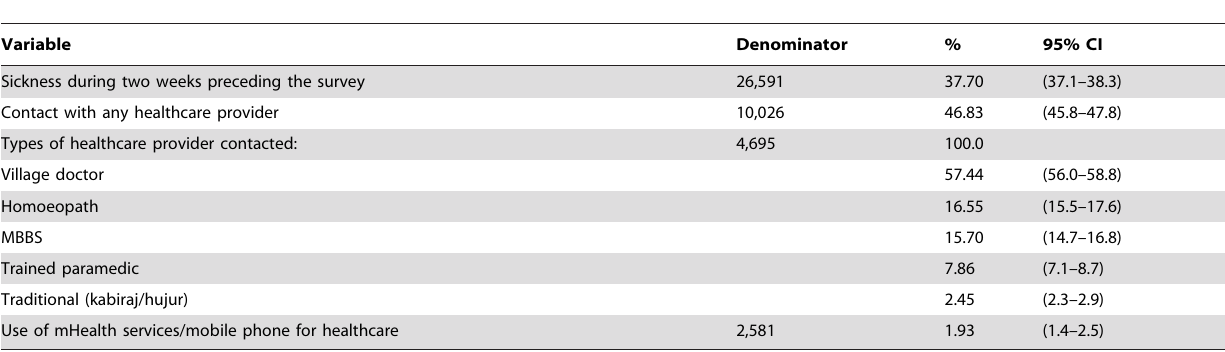
Table 6. Health seeking behavior during sickness.